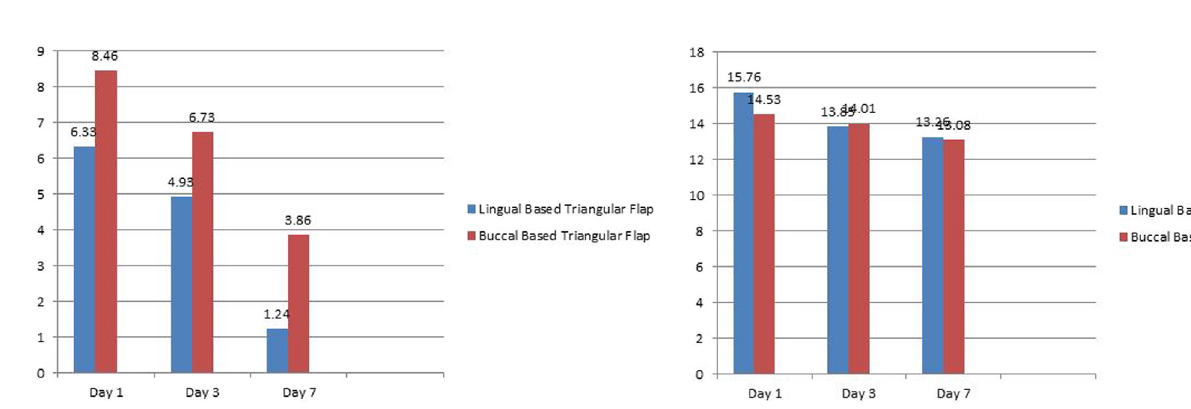
Fig. 6. The average pain scores (vas) between buccal based triangular fl ap and lingual based triangular fl ap.